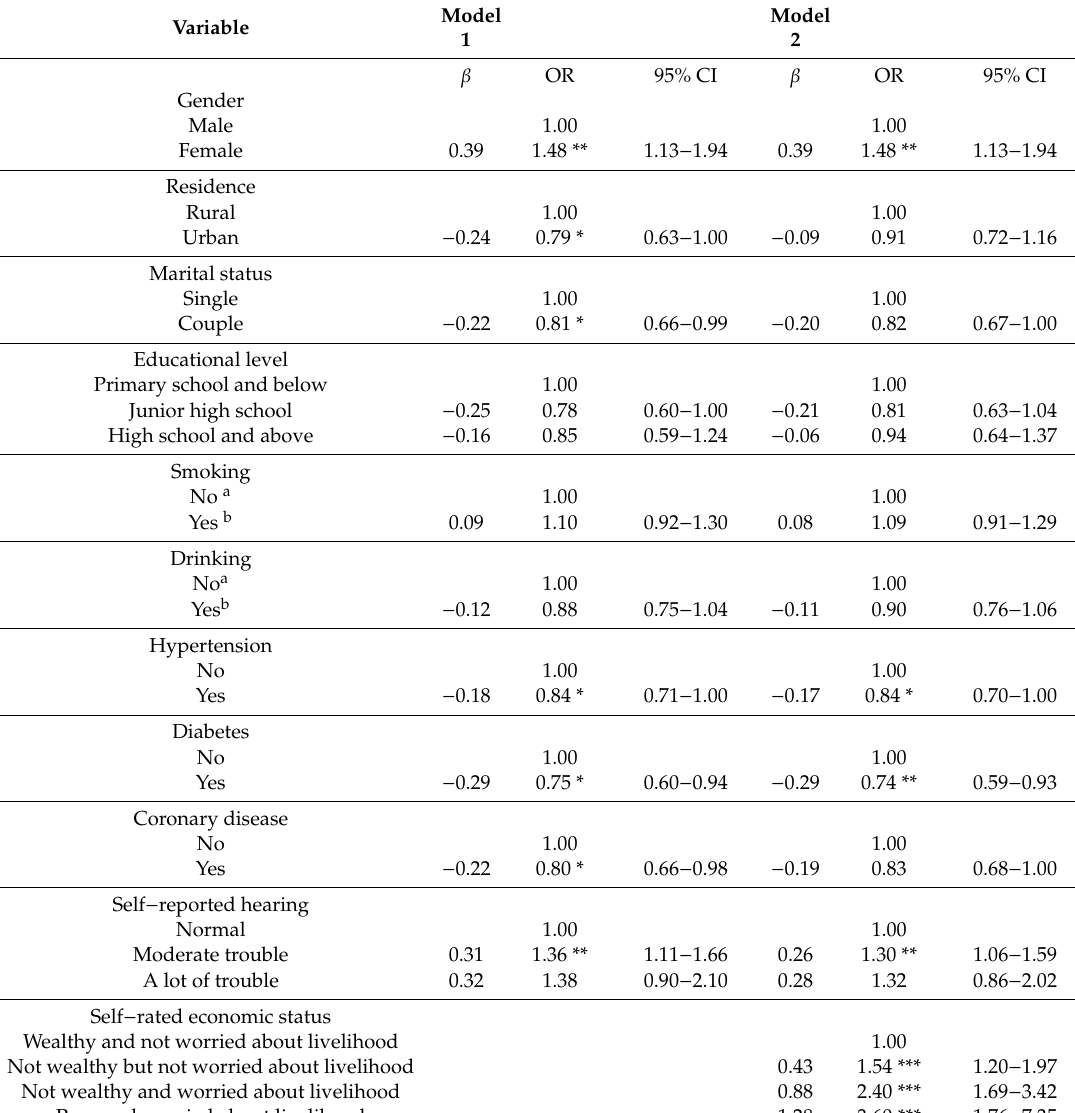
Table 2. Associations between self-rated economic status and falls in the past six months among the elderly in Shandong,